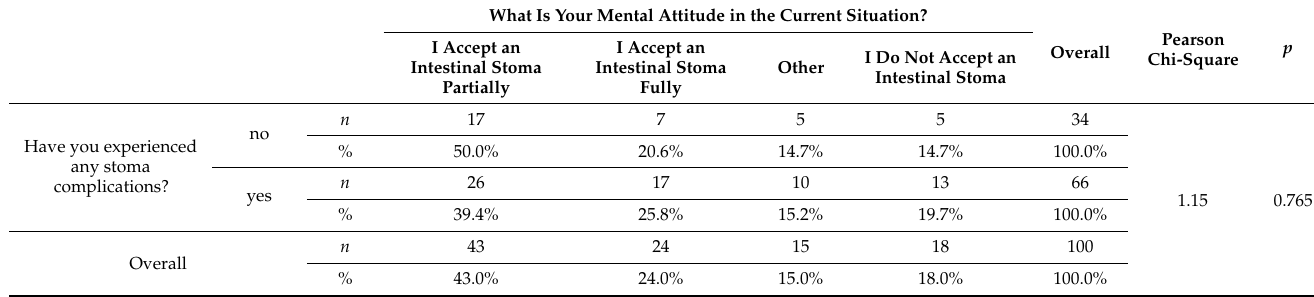
Table 7. Intestinal stoma acceptance and the incidence of stoma